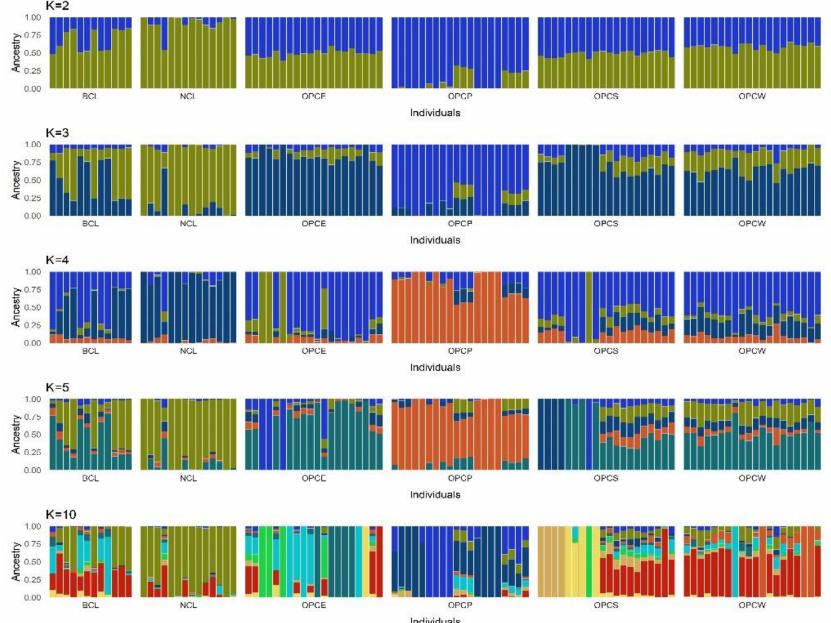
Figure 9. Model-based clustering using genotypic data from seven sheep breeds. K, Number of clusters, from 2 to 5, and 10. The best prediction model was K = 3. Each bar indicated an individual and each colour the membership to a particular cluster, the number of clusters is determined by the K value.